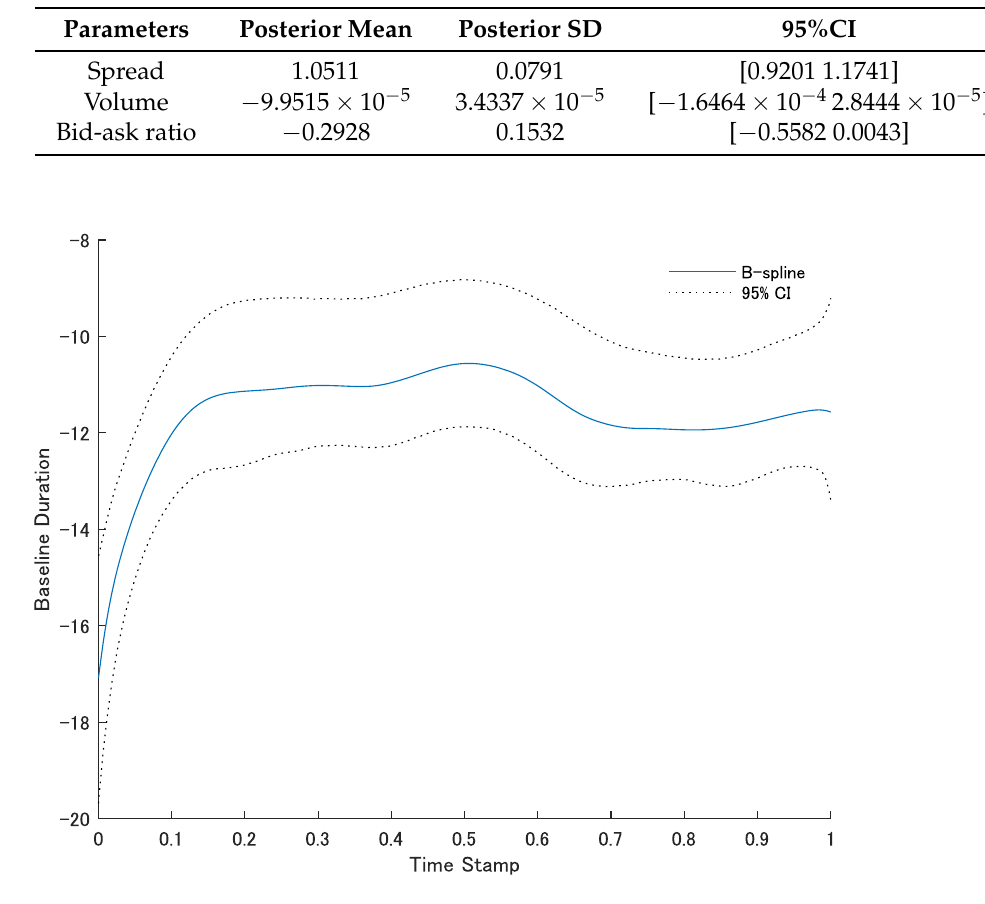
Figure 4. Intraday seasonality of time interval of AGH, Tokyo, Japan (4 January 2016).